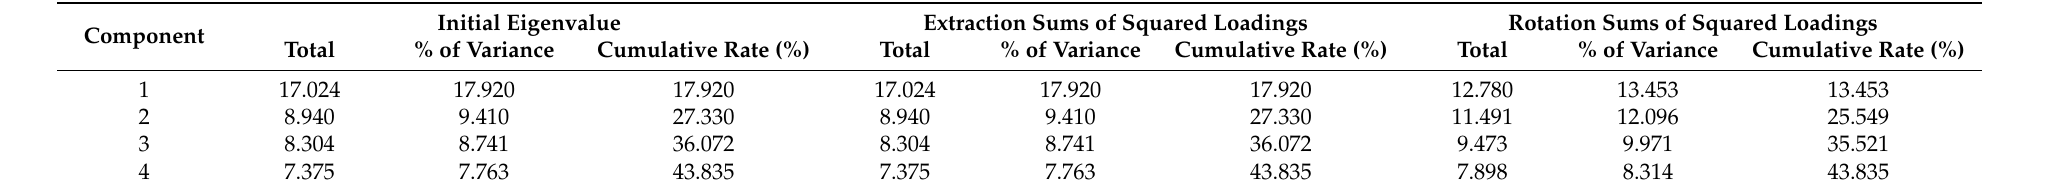
Table 3. Factor analysis results.